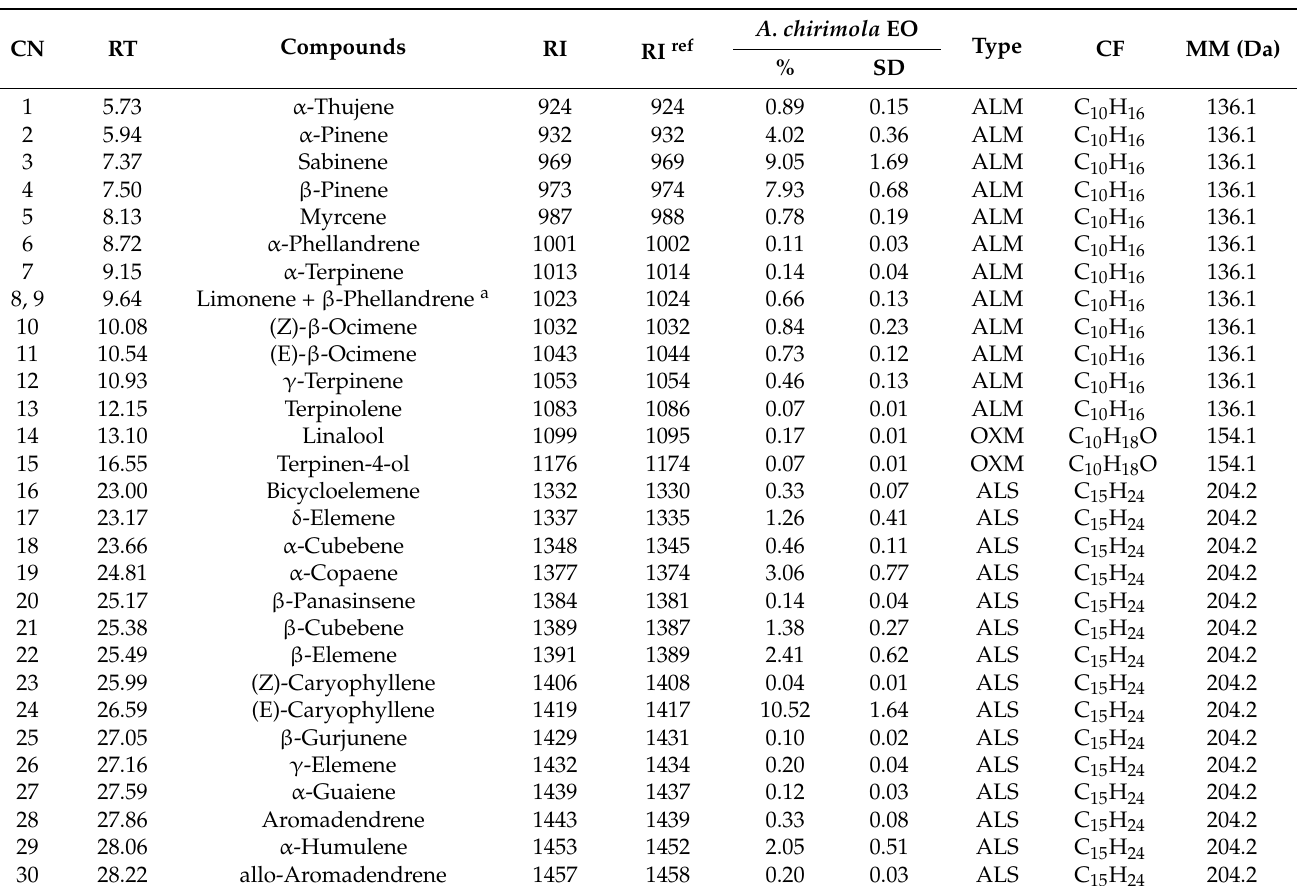
Table 2. Chemical composition of essential oil from Annona cherimola